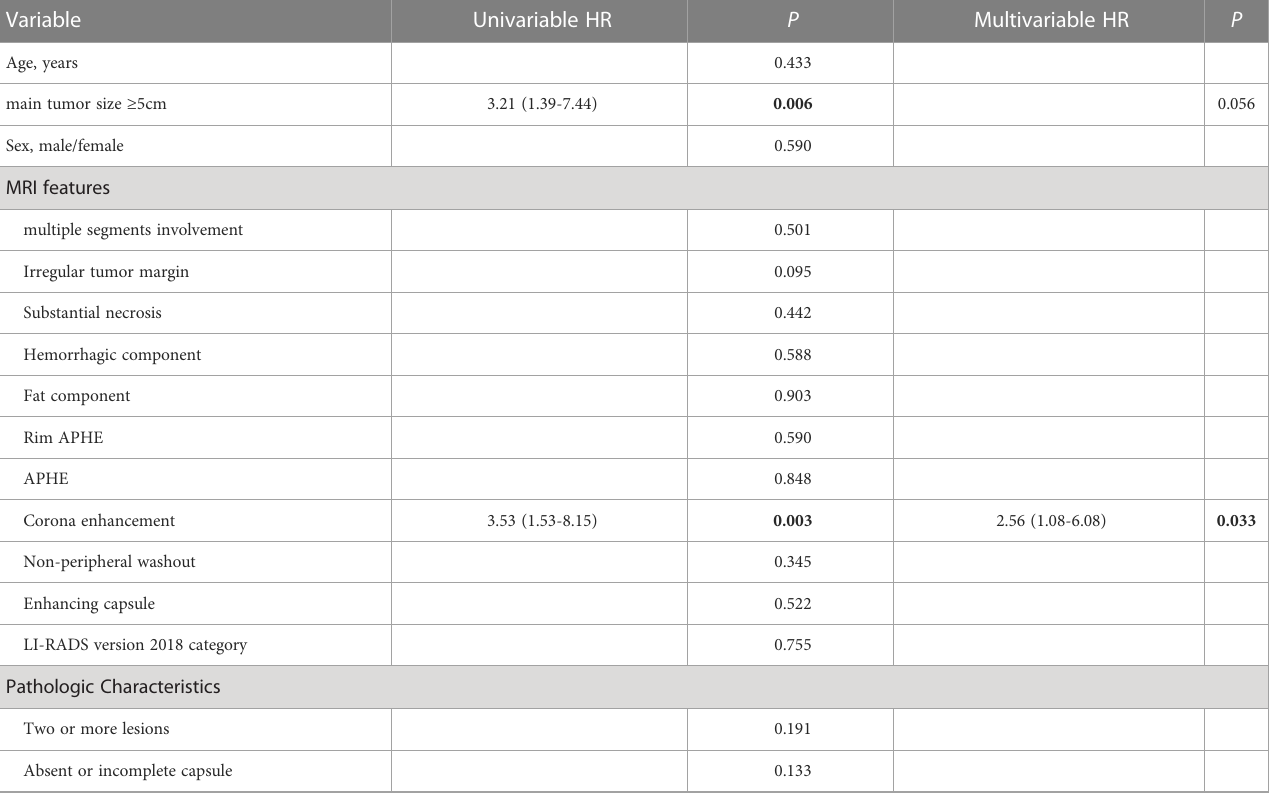
TABLE 5 Univariable and Multivariable Cox Regression Analysis for Early Recurrence of Hepatocellular Carcinoma in Primary Cohort after Surgical